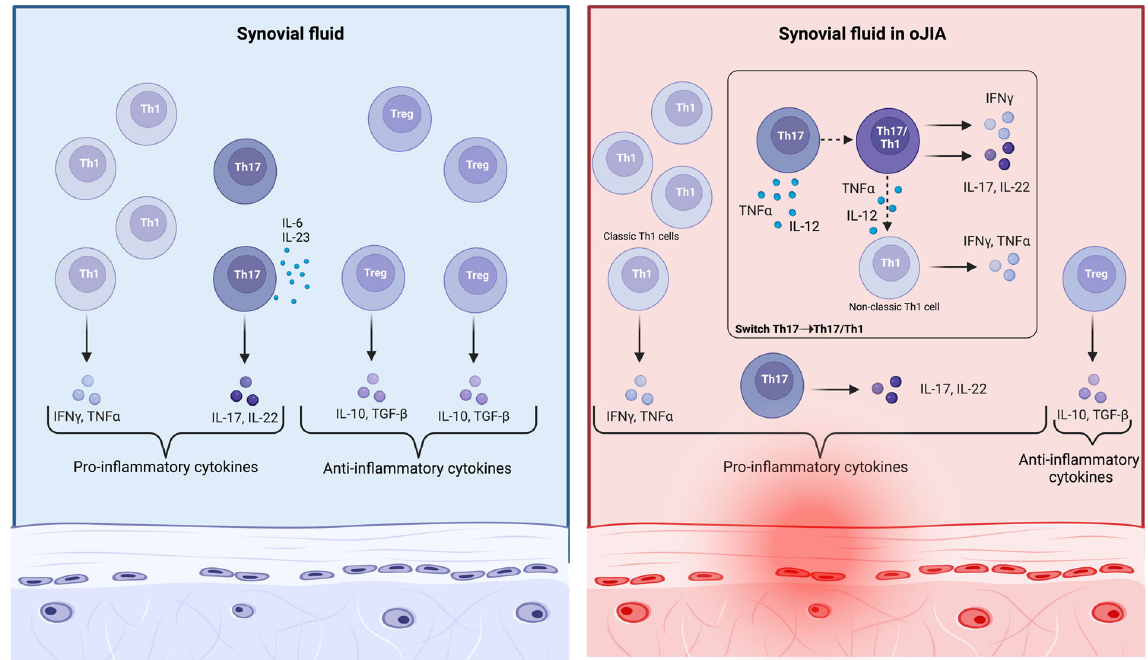
Figure 3. In the local inflammatory environment present in oJIA, CD4+ Th17 cells develop the ability to generate IFN γ when stimulated by cytokines such as IL ‐ 12 and TNF α . Such Th cells have an intermediate phenotype, known as Th17/Th1, and first generate both IFN γ and IL ‐ 17, and then only IFN γ . Both non ‐ classic Th1 cells and Th17/Th1 cells are highly present in inflamed joints, with a large amount of IL ‐ 17, IFN γ , and TNF α (created with “BioRender.com”, accessed on 28 December